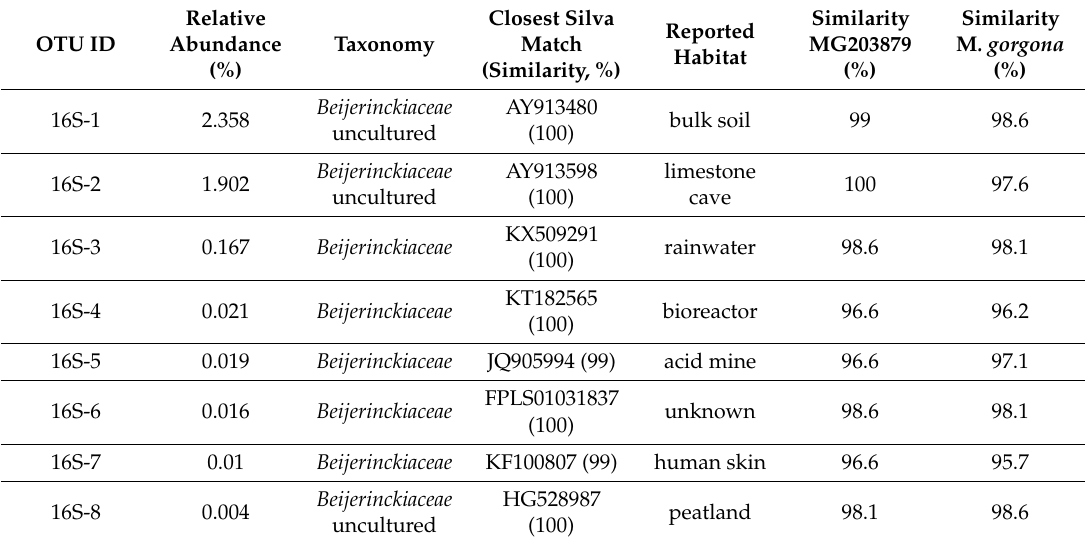
Table 3. Major operational taxonomic units (OTUs) of 16S rRNA gene sequences a ffi liated with the family Beijerinckiaceae